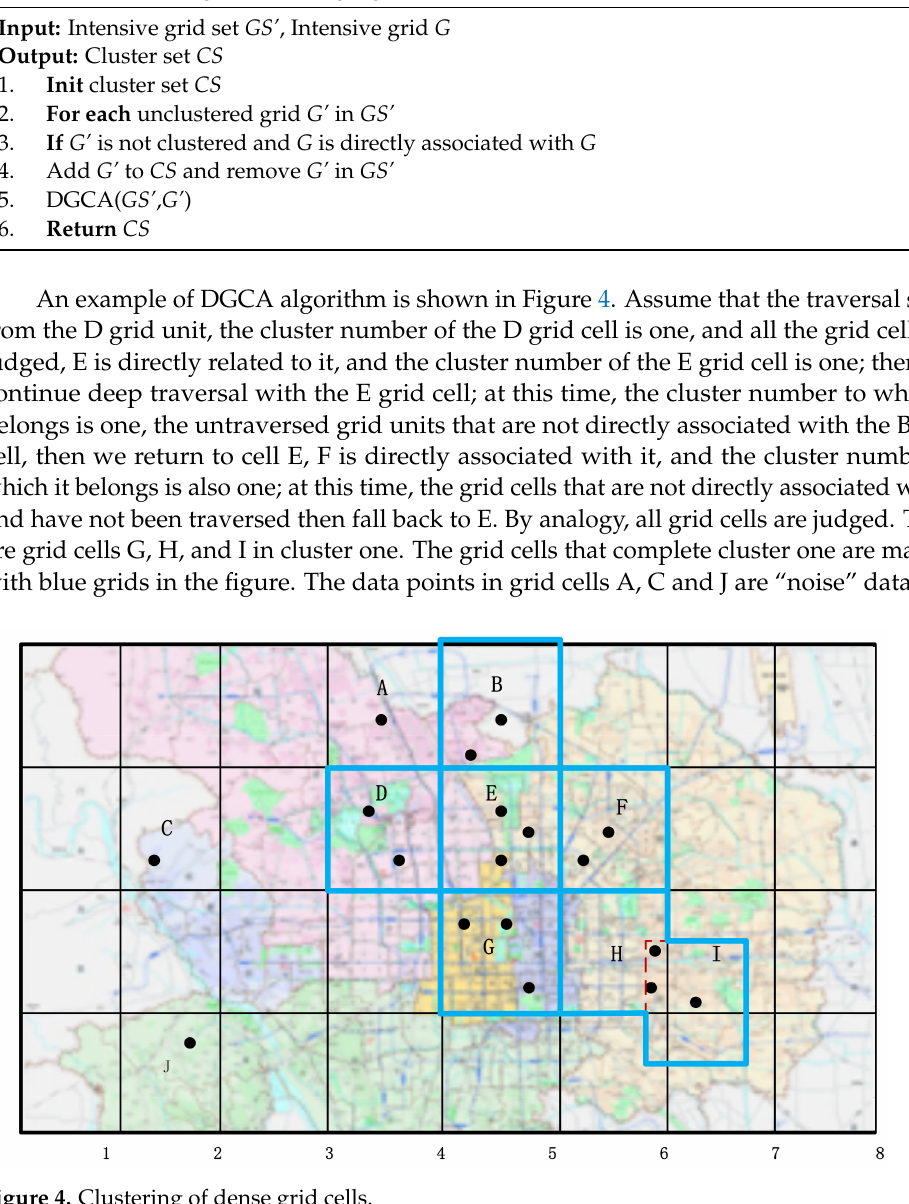
Figure 4. Clustering of dense grid